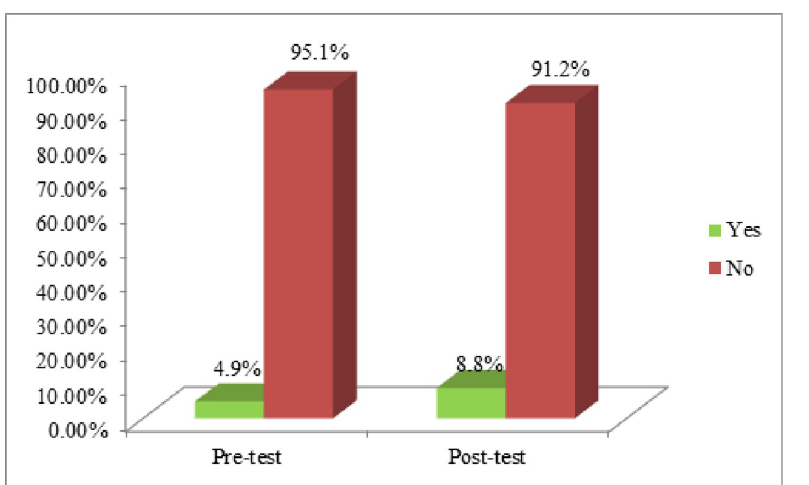
Fig 2. Comparison between pre-and post-test of participants based on the practice level of Pap test (n = 102).